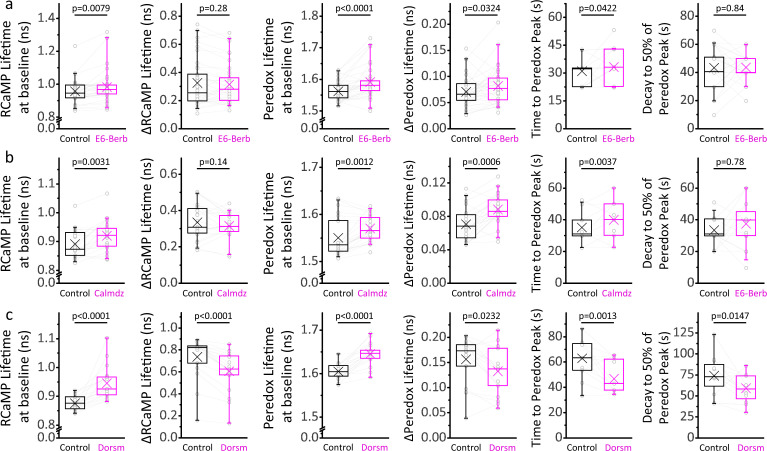
Ca2+/CaM and AMPK signaling modulates the cytosolic [Ca2+] and NADH/NAD+ ratio at baseline, and the time course of the NADHCYT transient in response to stimulation.(a) Inhibition of the Ca2+/CaM axis with 10 µM E6-berbamine (E6-Berb) increases the RCaMP lifetime at baseline while keeping the stimulus-associated RCaMP spike intact. The Peredox lifetime at baseline, the amplitude, and the time to peak of the NADHCYT transient are also increased with this treatment. The sample size corresponds to Figure 5a, except for the time course parameters (time to peak and decay), where only DGCs with ΔPeredox ≥ 0.05 ns were analyzed (Nneurons = 27). (b) Inhibition of the Ca2+/CaM axis with 20 µM calmidazolium (Calmdz) caused similar effects to E6-berbamine. Sample size as in Figure 5b; with Nneurons = 20 for the time course analysis, corresponding to neurons with ΔPeredox ≥ 0.05 ns. (c) Inhibition of AMPK with 10 µM dorsomorphin (Dorsm) increased the RCaMP and Peredox baselines but decreased the RCaMP transients in response to stimulation. Sometimes the slices were stimulated with 150 pulses instead of 100 (before and after treatment) to ensure effective stimulation of the somata throughout the experiment. Sample size as in Figure 5c; with Nneurons = 16 for the time course analysis, corresponding to neurons with ΔPeredox ≥0.05 ns. A paired Student’s t test was used for comparisons between normally distributed data, or a non-parametric paired Wilcoxon test was used otherwise.